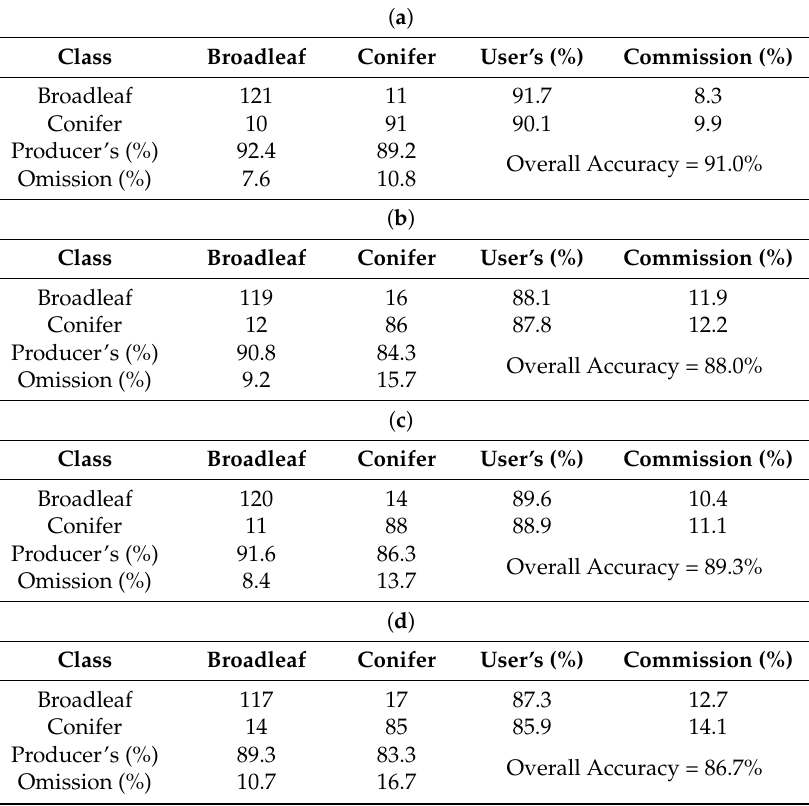
Table 8. Confusion matrix (including overall accuracies, per-class user’s and producer’s accuracies) for two forest-types classification using the validation dataset: ( a ) classification using the three most important metrics (LiDAR and sunlit hyperspectral metrics); ( b ) classification using the three most important metrics (LiDAR and crown hyperspectral metrics); ( c ) classification using the three most important metrics (Sunlit hyperspectral metrics); and ( d ) classification using the three most important metrics (Crown hyperspectral